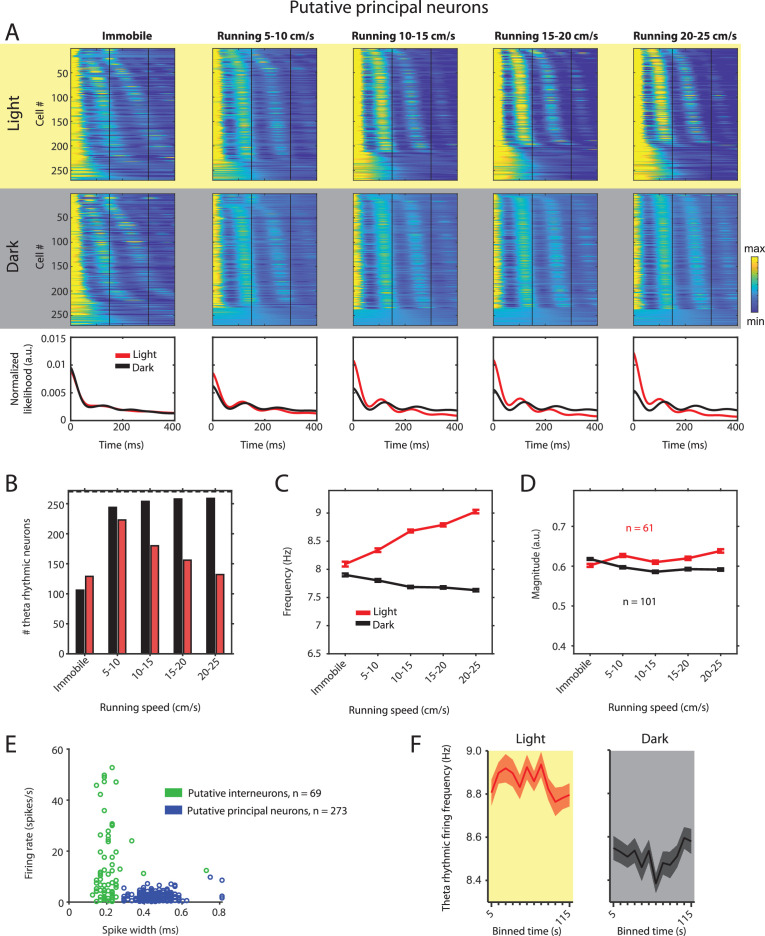
Theta rhythmic firing as a function of running speed and visual inputs in putative principal neurons.Red color or yellow background indicates data on the light condition, black and gray color or gray background indicates data on the dark condition. (A) Upper panels show the color coded MLE autocorrelogram models for each of n = 270 putative principal neurons at different running speed intervals. Immobility was defined as running speed <3 cm/s. Neurons are sorted per condition in order of their theta rhythmic firing frequency. Bottom row shows the average across autocorrelogram models per condition. Note that higher synchrony across neurons results in higher rhythmicity magnitude in the average across neurons. (B) Number of neurons shown in A with statistically significant spiking rhythmicity at alpha = 0.1 determined by the MLE model for different running speeds in light and dark. (C, D) Longitudinal analysis of frequency (C) and magnitude (D) of theta rhythmic firing of neurons with significant theta rhythmic firing across all running speed bins (light: n = 61 neurons; dark: n = 101 neurons). Data show mean ± s.e.m. (E) Classification of theta rhythmic neurons into putative principal neurons (blue) and putative interneurons (green) based on the spike width and firing rate (see Materials and methods). (F) Theta rhythmic firing frequency plotted for consecutive 10 s time bins after the start of light and dark conditions. Theta rhythmic firing frequency was not correlated with time after start of light (p=0.3688) or dark (p=0.8898) conditions.